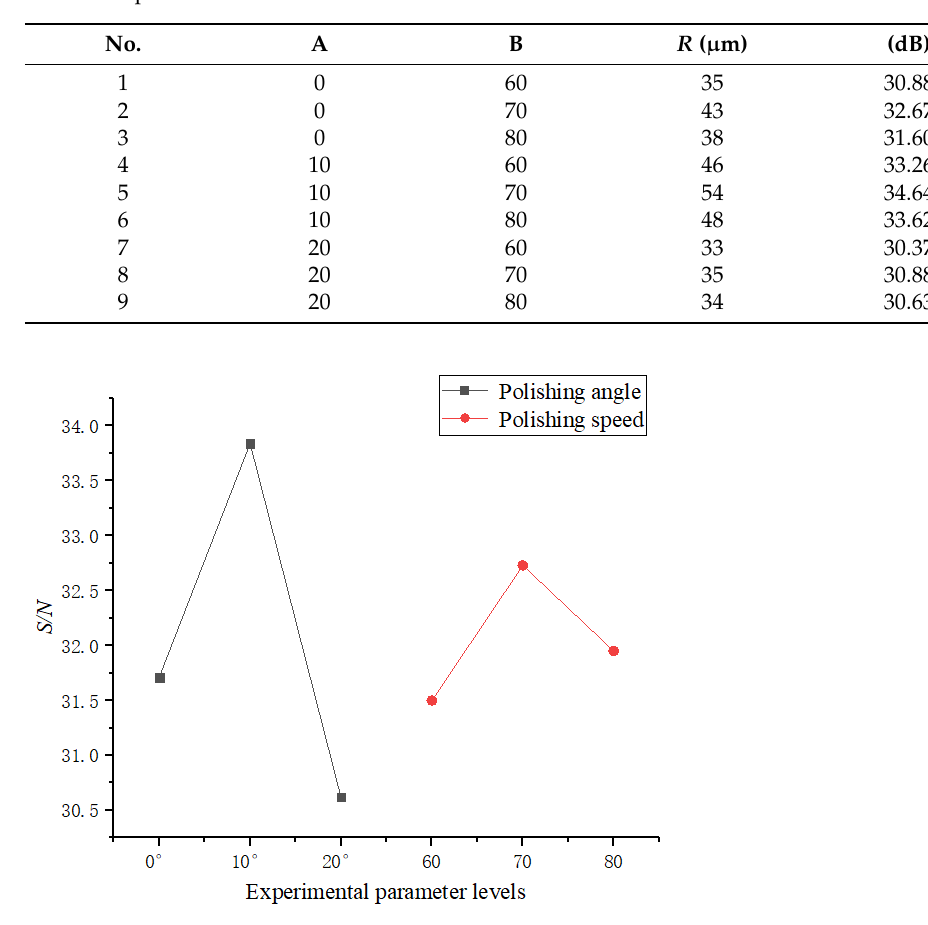
Table 4. Experimental results.